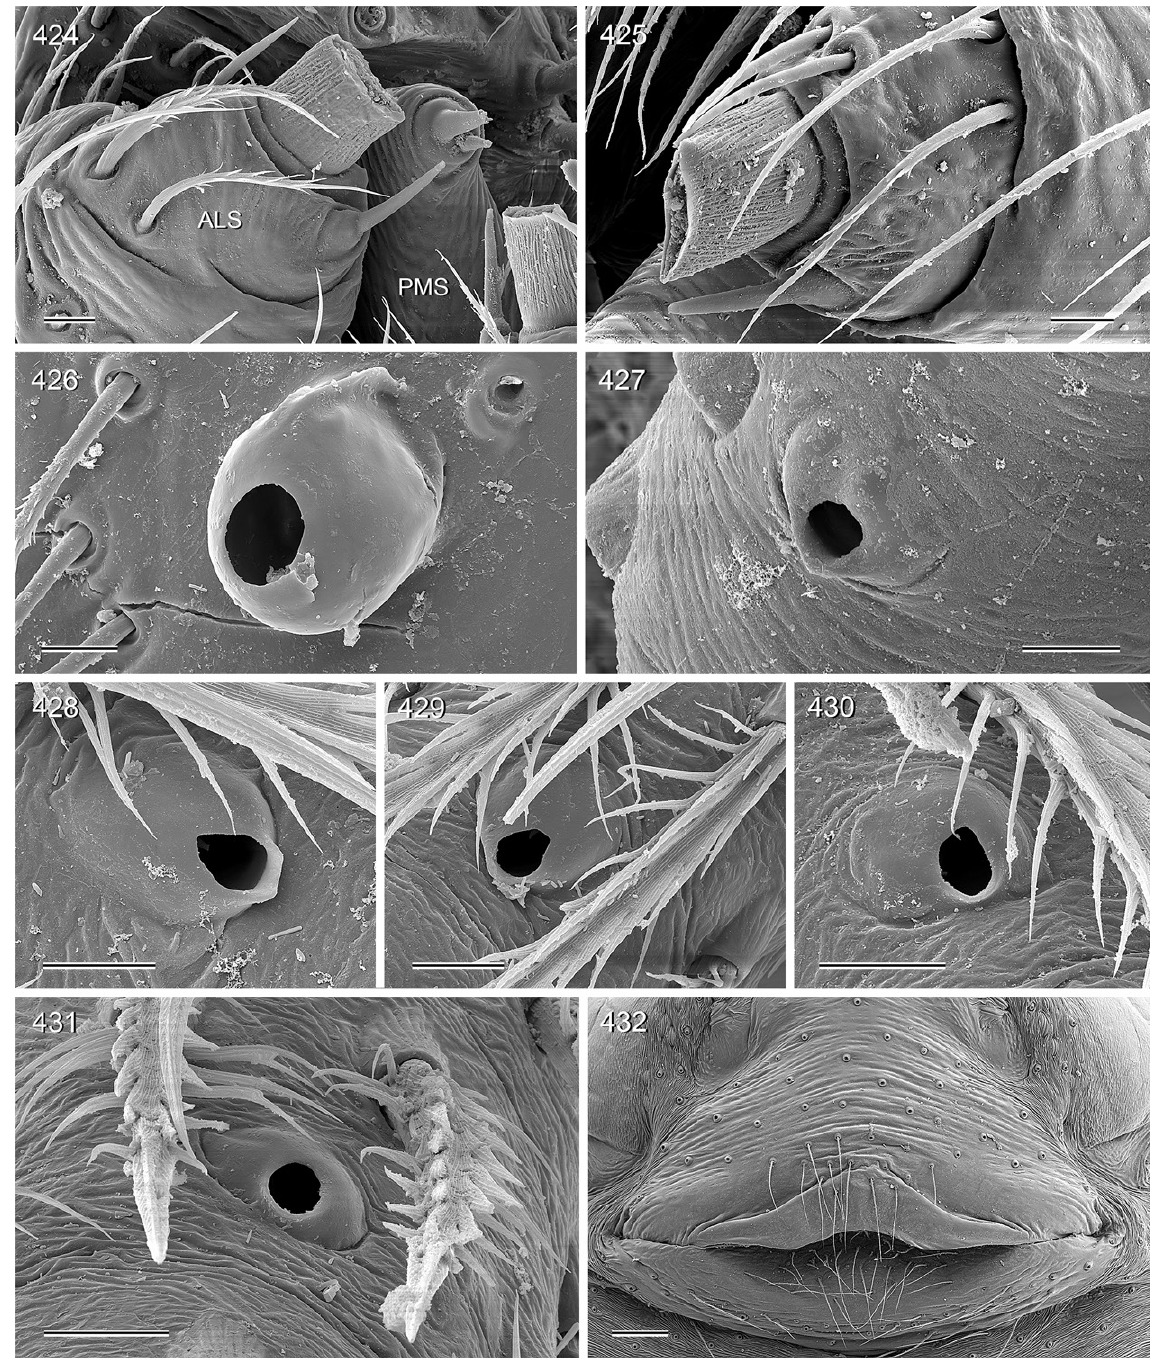
Figs 424–432. Crossopriza sahtan sp. nov.; male and female from Oman, Al Ghubrat cave